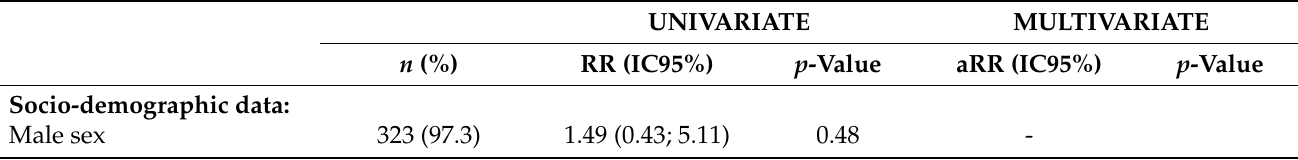
Table 4. Factors associated with high accumulation of mtDNA